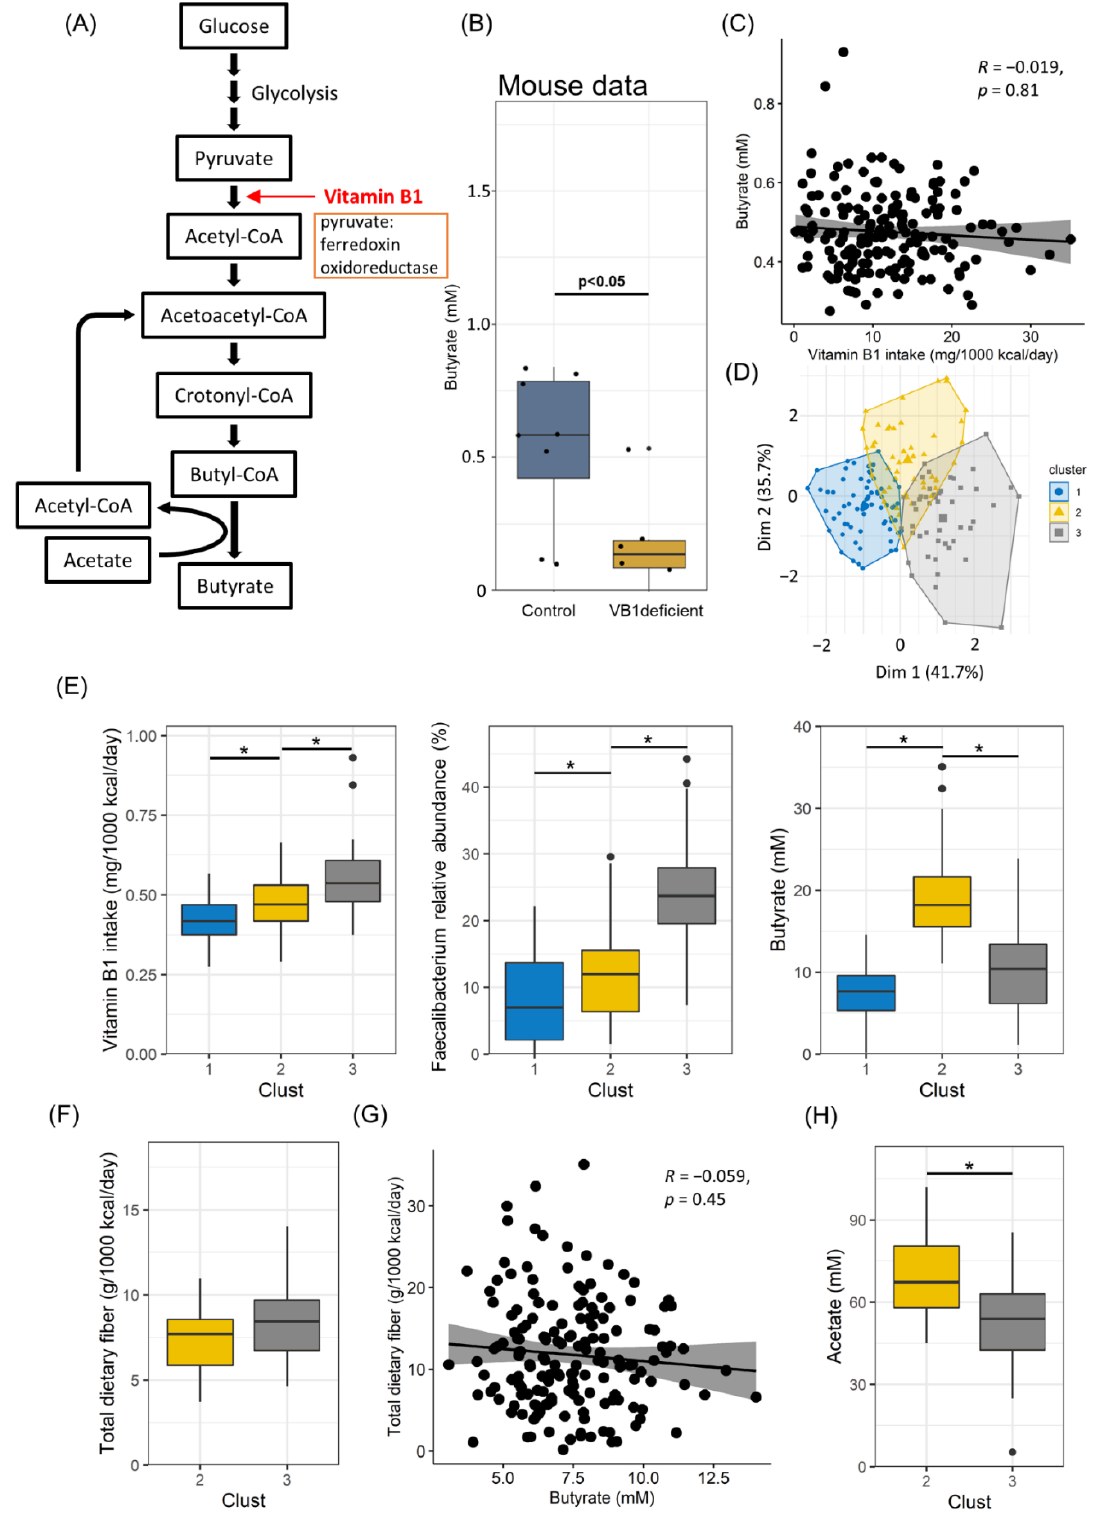
Figure 4. Effects of dietary fiber and gut bacteria on butyrate production. ( A ) Pathways for butyrate synthesis in Faecalibacterium . ( B ) Boxplot for comparison between the vitamin B1-deficient and control groups in terms of the amount of butyrate in mouse fecal samples. ( C ) Correlation between butyrate and vitamin B1 intake is shown by scatterplots. ( D ) HCPC analysis of vitamin B1 yield, butyrate amount in feces, and relative abundance of Faecalibacterium . ( E ) Boxplot for vitamin B1 intake